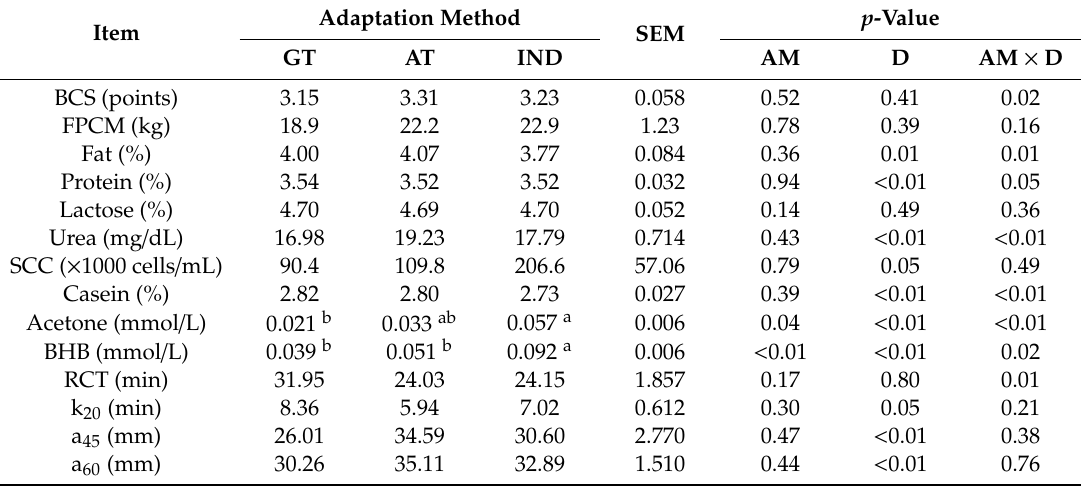
Table 1. Mean values of body condition score (BCS) and milk yield, composition, and coagulation properties (MCP) ( n =